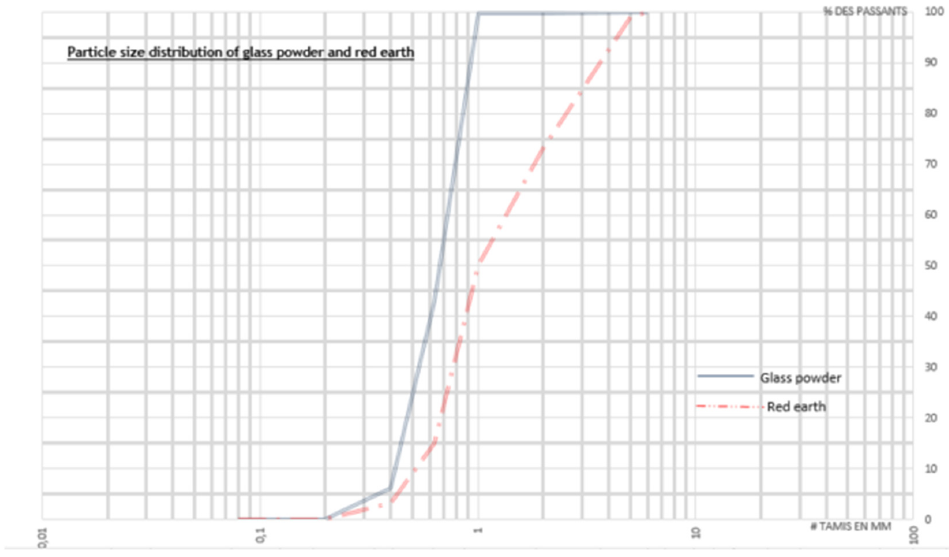
Figure 1. Particle size distribution of glass powder and red earth. Table 1. Chemical composition of glass powder, cement and red earth. Element